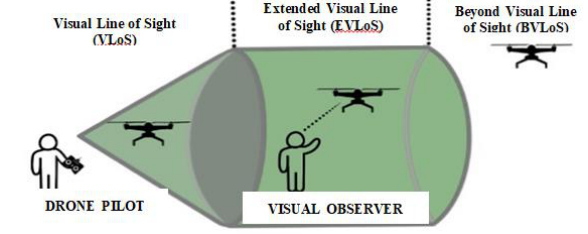
Figure 3 . VLOS, BVLOS, EVLOS visual representation.